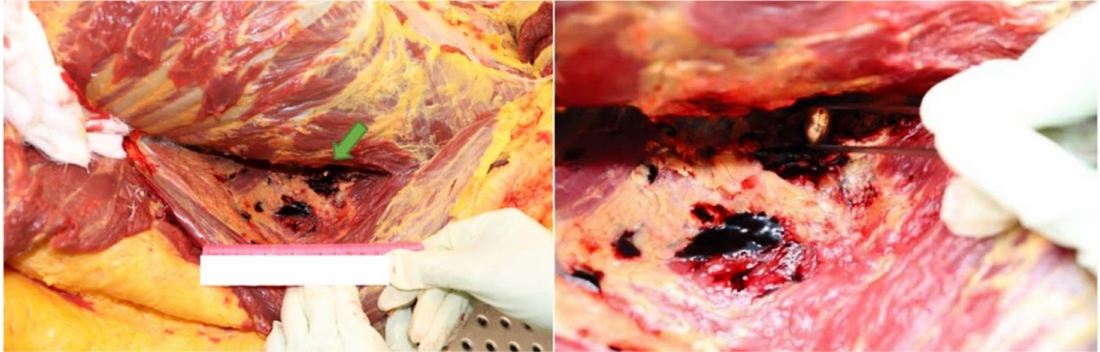
Figure 6. The retained 9 mm bullet (green arrow) found embedded between the internal oblique muscle and the transversus abdominis